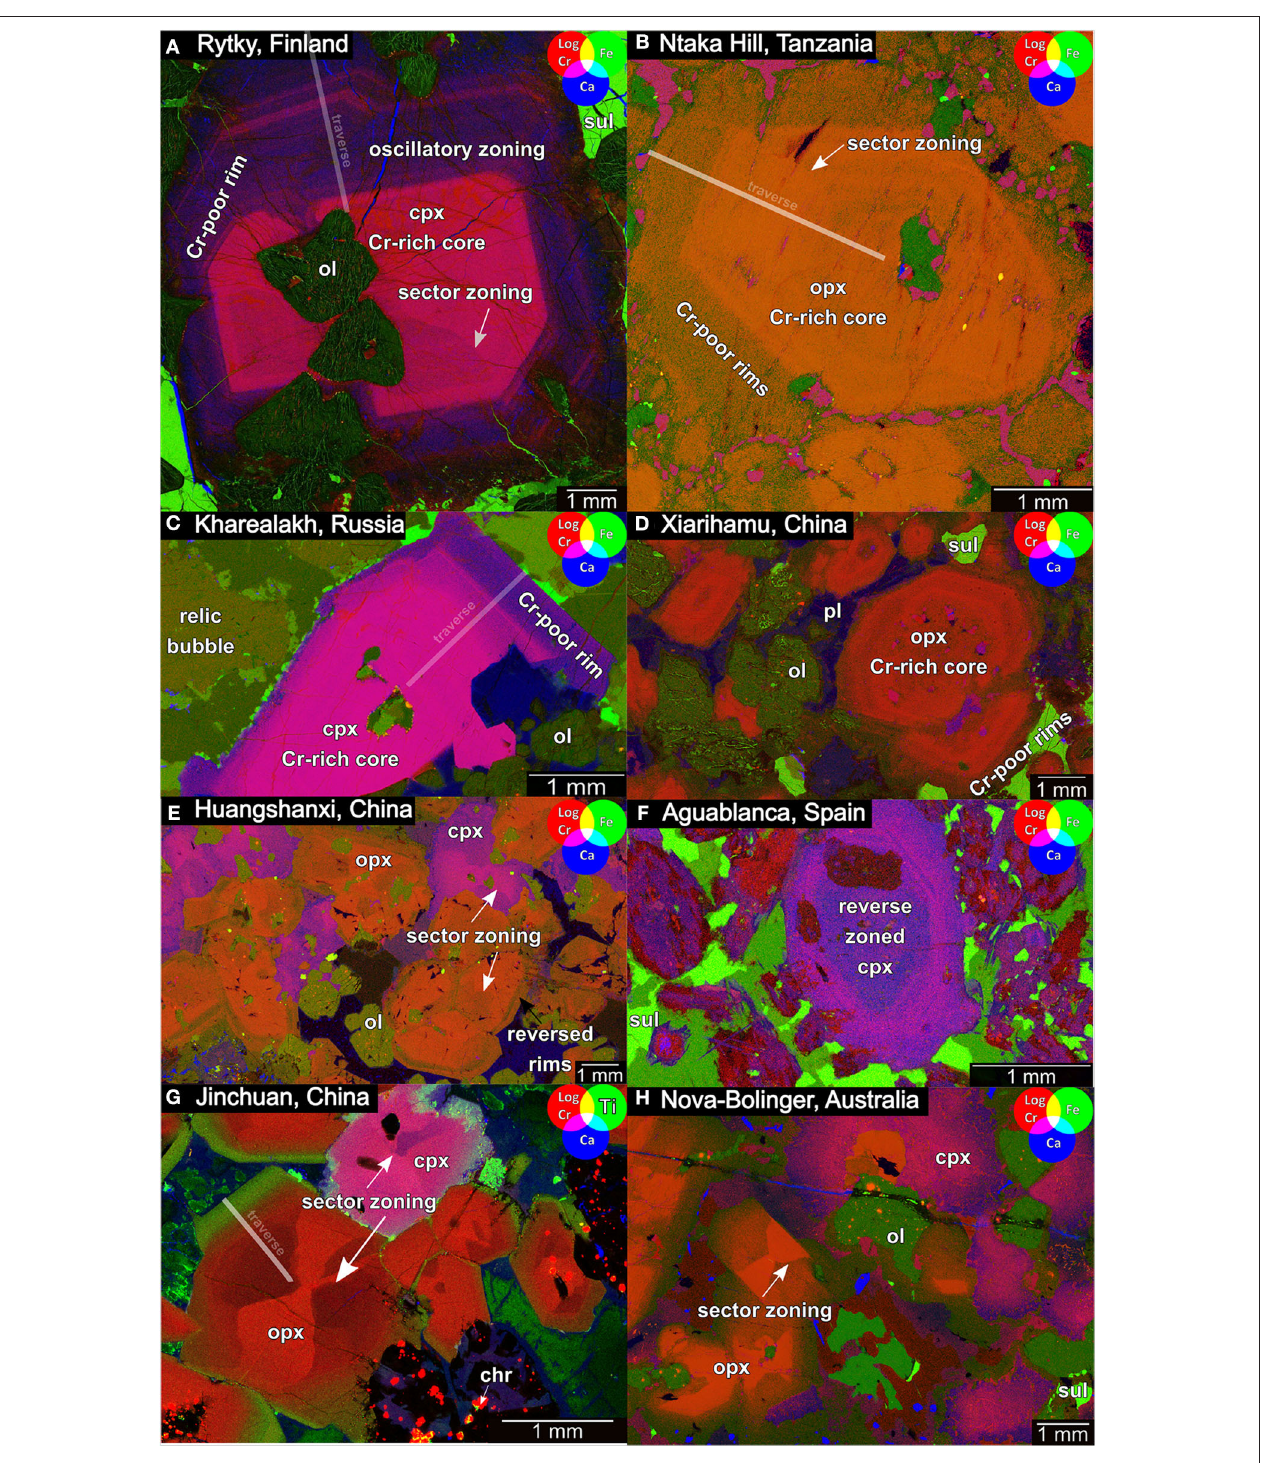
FIGURE 3 | X-ray Fluorescence (XRF) images collected from the Australian Synchrotron of zoned pyroxenes in Ni-Cu magmatic sulfide deposits from around the world. (A) Rytky, (B) Ntaka Hill, (C) Kharealakh (Talnakh), (D) Xiarihamu, (E) Huangshanxi, (F) Aguablanca, (G) Jinchuan, and (H) Nova-Bollinger. Stacked false color (RGB) image of logged chromium concentration in red, iron or titanium in green and calcium in blue. Clinopyroxene [Ca(Mg,Fe)Si 2 O 6 ] is displayed in pink (Cr-rich) to purple (Cr-poor) while orthopyroxene [(Mg,Fe)SiO 3 ] is orange (Cr-rich) to green (Cr-poor) in colouration. Mineral abbreviations: cpx, clinopyroxene; ol, olivine; opx, orthopyroxene; pl, plagioclase; S,